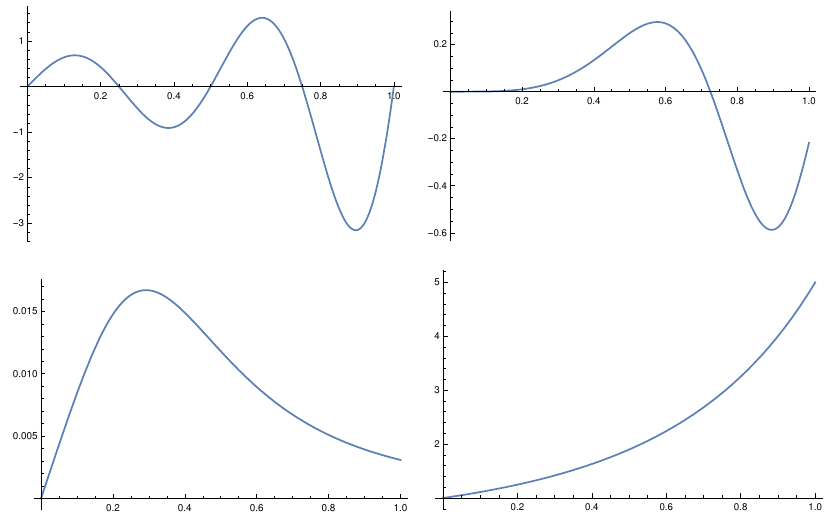
Figure 3. Plots of test functions: k 1 , k 2 , k 3 and k 4 (from ( left ) to ( right ) and from ( top ) to ( bottom